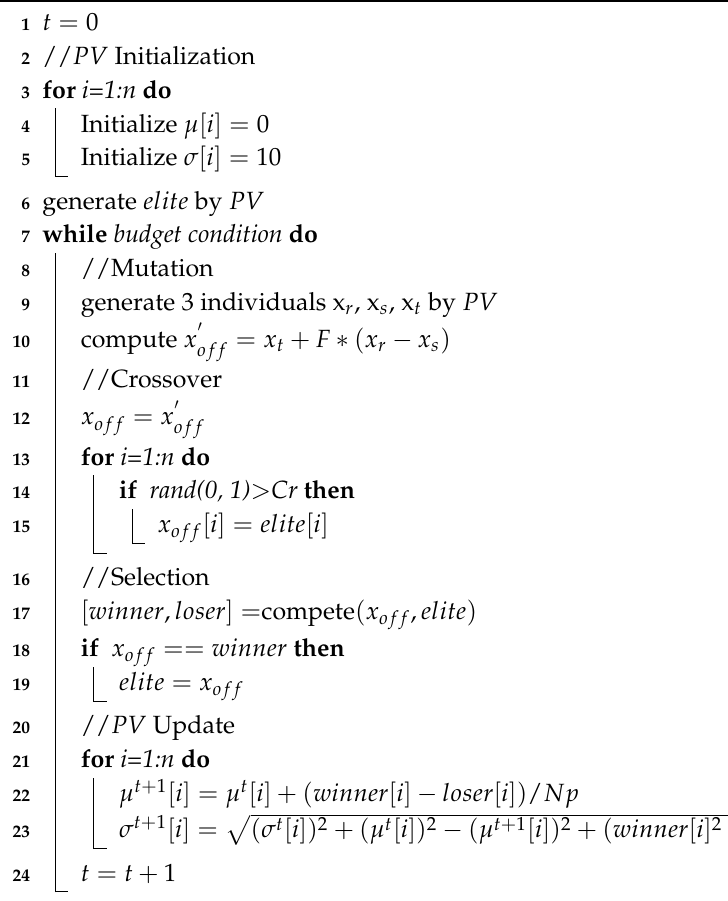
Algorithm 2: pe-cDE algorithm pseudocode